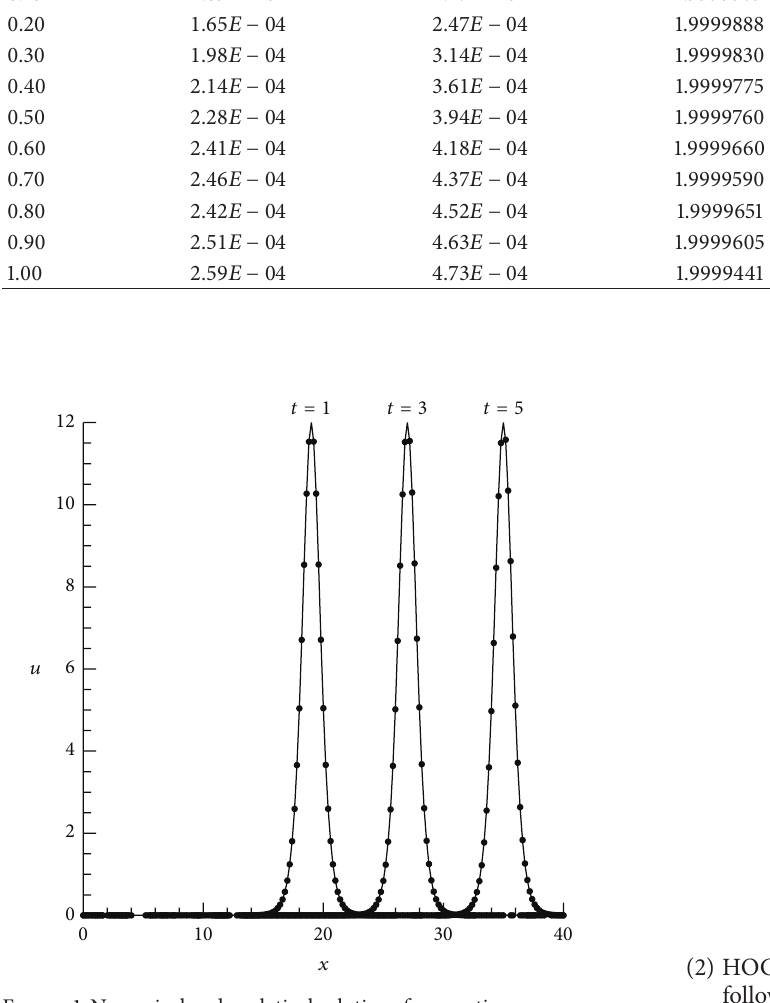
Figure 1: Numerical and analytical solutions for equation 𝑢 𝑡 +𝑢𝑢 𝑥 + = 0 of Example 2 at various time 𝑢 𝑥𝑥𝑥